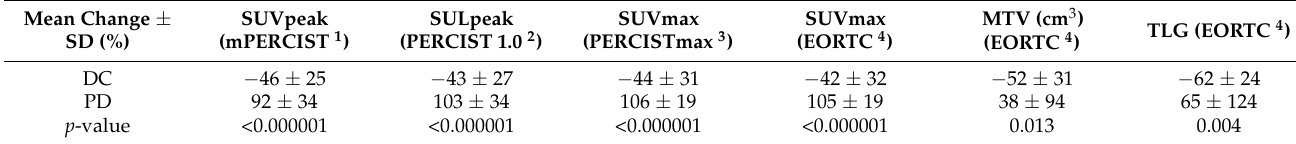
Table 4. Mean changes of PET parameters in patients classified as disease control (DC) and progressive disease (PD) according to all PERCIST and EORTC criteria; DC = disease control; PD = progressive disease; PERCIST 1.0 = PET Response Criteria in Solid Tumors; EORTC = European Organization for Research and Treatment of Cancer; mPERCIST = modified PERCIST using SUVpeak; PERCISTmax = modified PERCIST using SUVmax. Mean Change ± SUVpeak SULpeak SD (%) (mPERCIST 1 ) (PERCIST 1.0 2